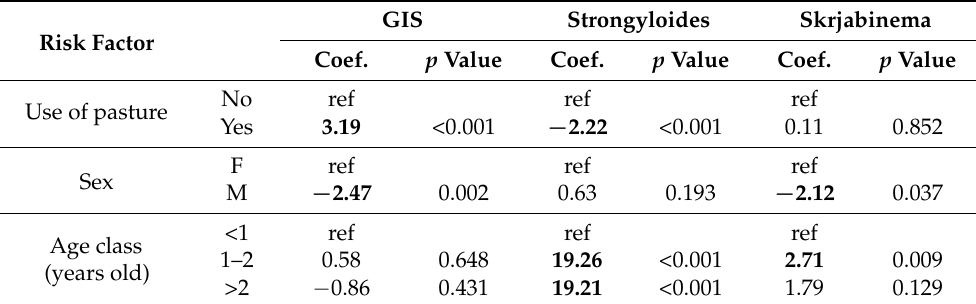
Table 3. Results of negative binomial regression model for GIS, Strongyloides and Skrjabinema , considering all sampled animals (n = 256). Significant values are highlighted in bold.